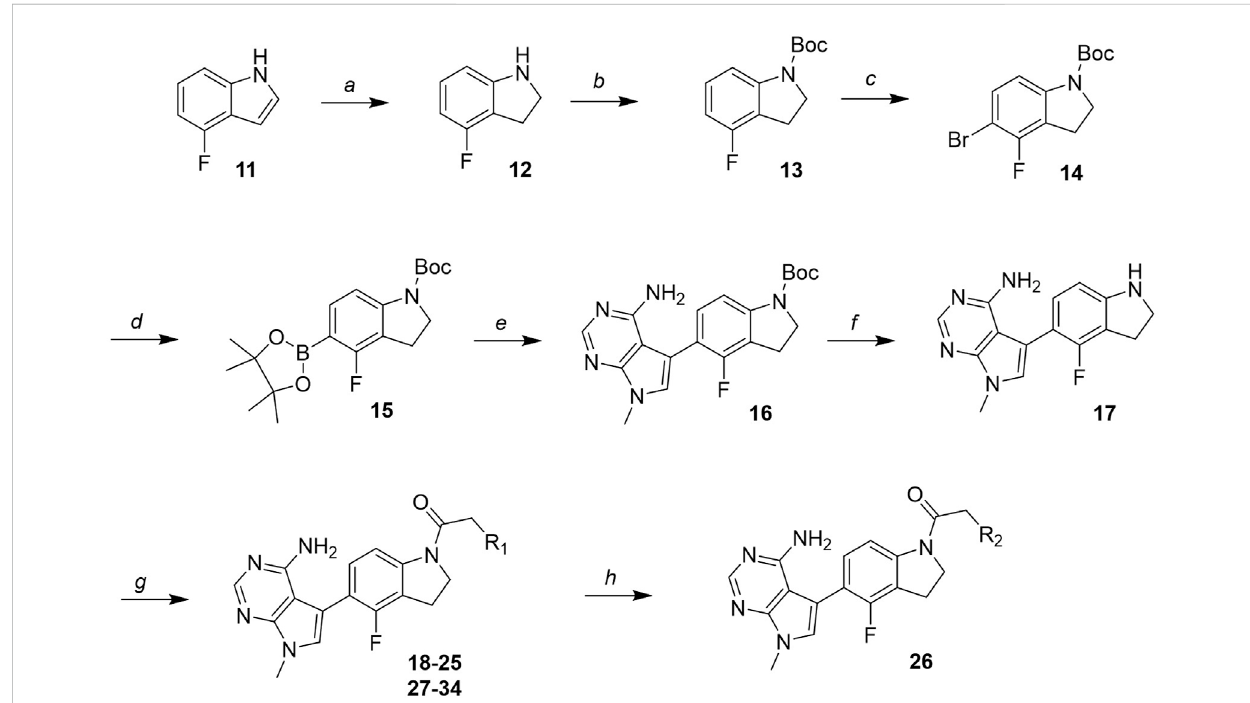
FIGURE 3 Synthesis of the common intermediate 17 based on GSK ’ 157 synthetic route followed by amide coupling to obtain novel RIPK1 inhibitors 18 – 34 . Reagents and conditions: (a) 4- fl uoro-1 H -indole, NaBH 3 CN, AcOH, 0 ° C, 10 min, rt, 1 h; (b) Boc 2 O, DMAP, DCM, rt, 48 h; (c) NBS, DCM, rt, 1 h; (d) bis(pinacolato)diboron,KOAc,1,4-dioxane, water,80 ° Cfor 16 h(e)(t-Bu) 3 PHBF 4 ,Pd 2 (dba) 3 , 90 ° C,2 h; (f)HClin1,4-dioxane4N,1,4-dioxane,rt,16 h;(g) HATU, corresponding carboxylic acid, DIPEA, DMF, rt, 16 h; (h) 23, BBr 3 , DCM, 0 ° C, 48 h.